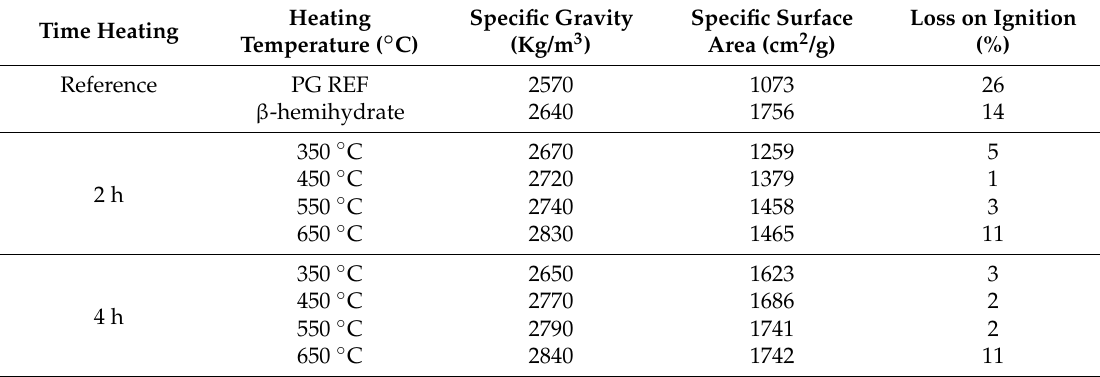
Table 1. Physical properties of dried phosphogypsum (PG REF), β -hemihydrate, and phosphoanhydrite (PA).